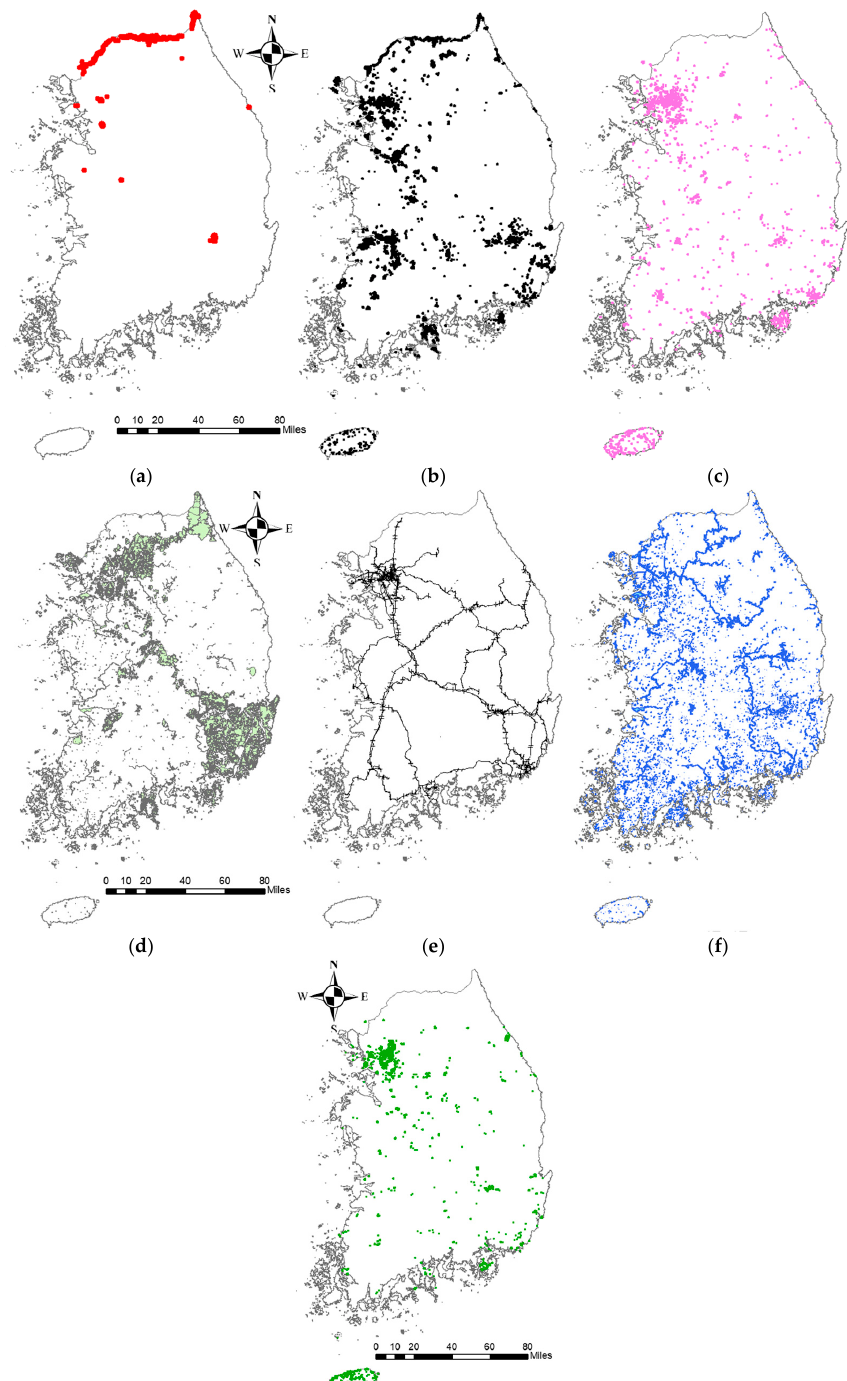
Figure 2. Restricted areas for wind farm development ( a ) R1: Military Zones and Protected Areas ( b ) R2: Land Under Use ( c ) R3: Tourism, Historic, Cultural and Religious Places ( d ) R4: Natural and Federal Areas ( e ) R5: Railways and Subways Network ( f ) R6: Wetlands, Rivers, Lakes, Water reservoirs and Streams ( g ) R7: Public and Community Interest Places.